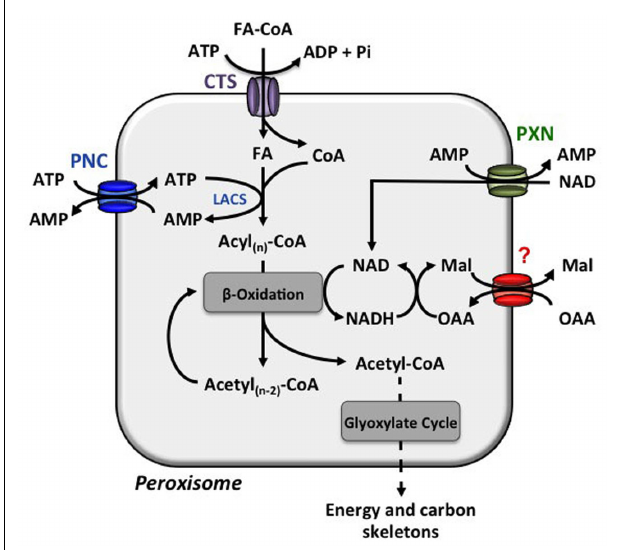
FIGURE 1 |Transport processes across the peroxisome membrane involved in β -oxidation. The COMATOSE (CTS) transporter facilitates the import of fatty acids from the cytosol to the peroxisomal matrix.The peroxisomal long-chain acyl-coenzyme A synthetase (LACS) activates the free fatty acid (FA) to enter β -oxidation for a stepwise release of acetyl-CoA. For the energy consuming esterification of FAs with coenzyme A (CoA), ATP is required and provided by the import via the PCN proteins.The released AMP is the counter-substrate for the next round of ATP import.The reduction equivalent NAD is reduced during β -oxidation.The PXN transport most likely imports NAD to set-up a sufficient NAD pool in the peroxisomes and the main route for NADH regeneration is enabled via the not yet molecularly identified oxaloacetate (OAA)–malate (Mal) shuttle